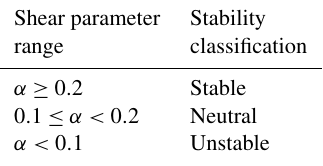
Table 2. Stability classifications used in this work. Shear parameter